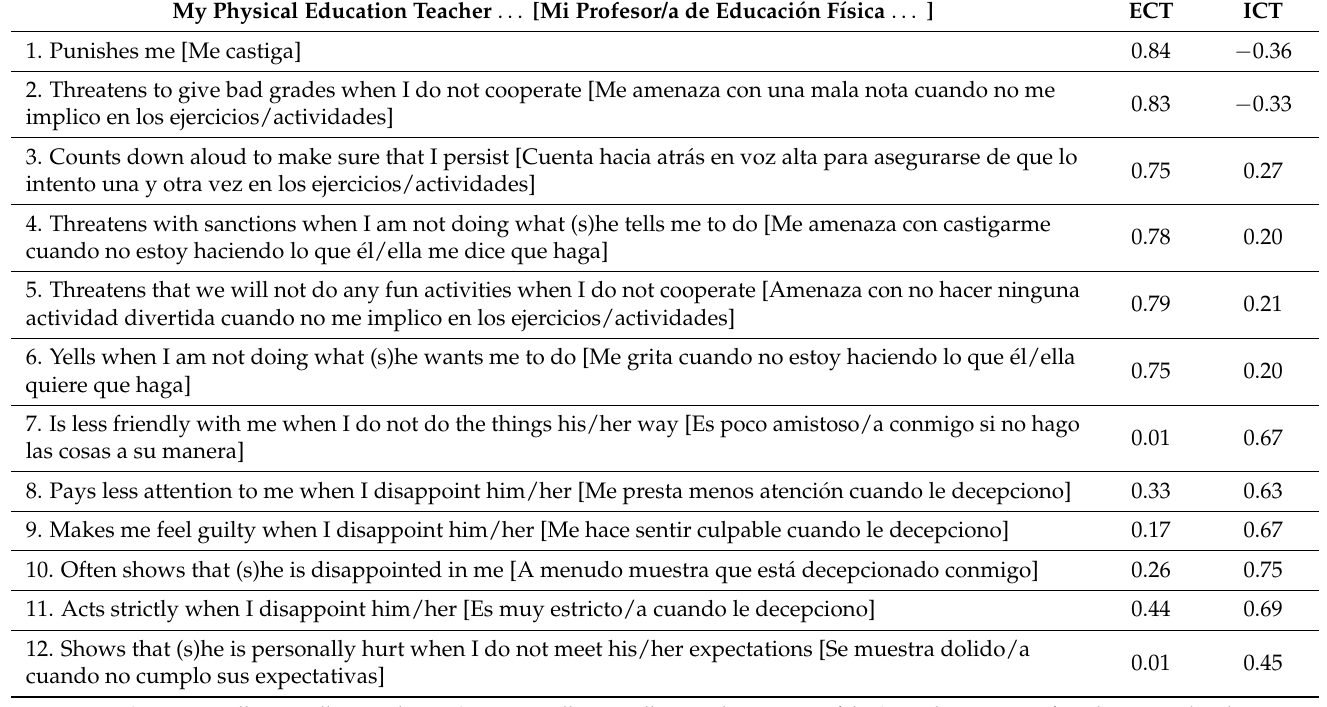
Table 1. Results from the EFA of the